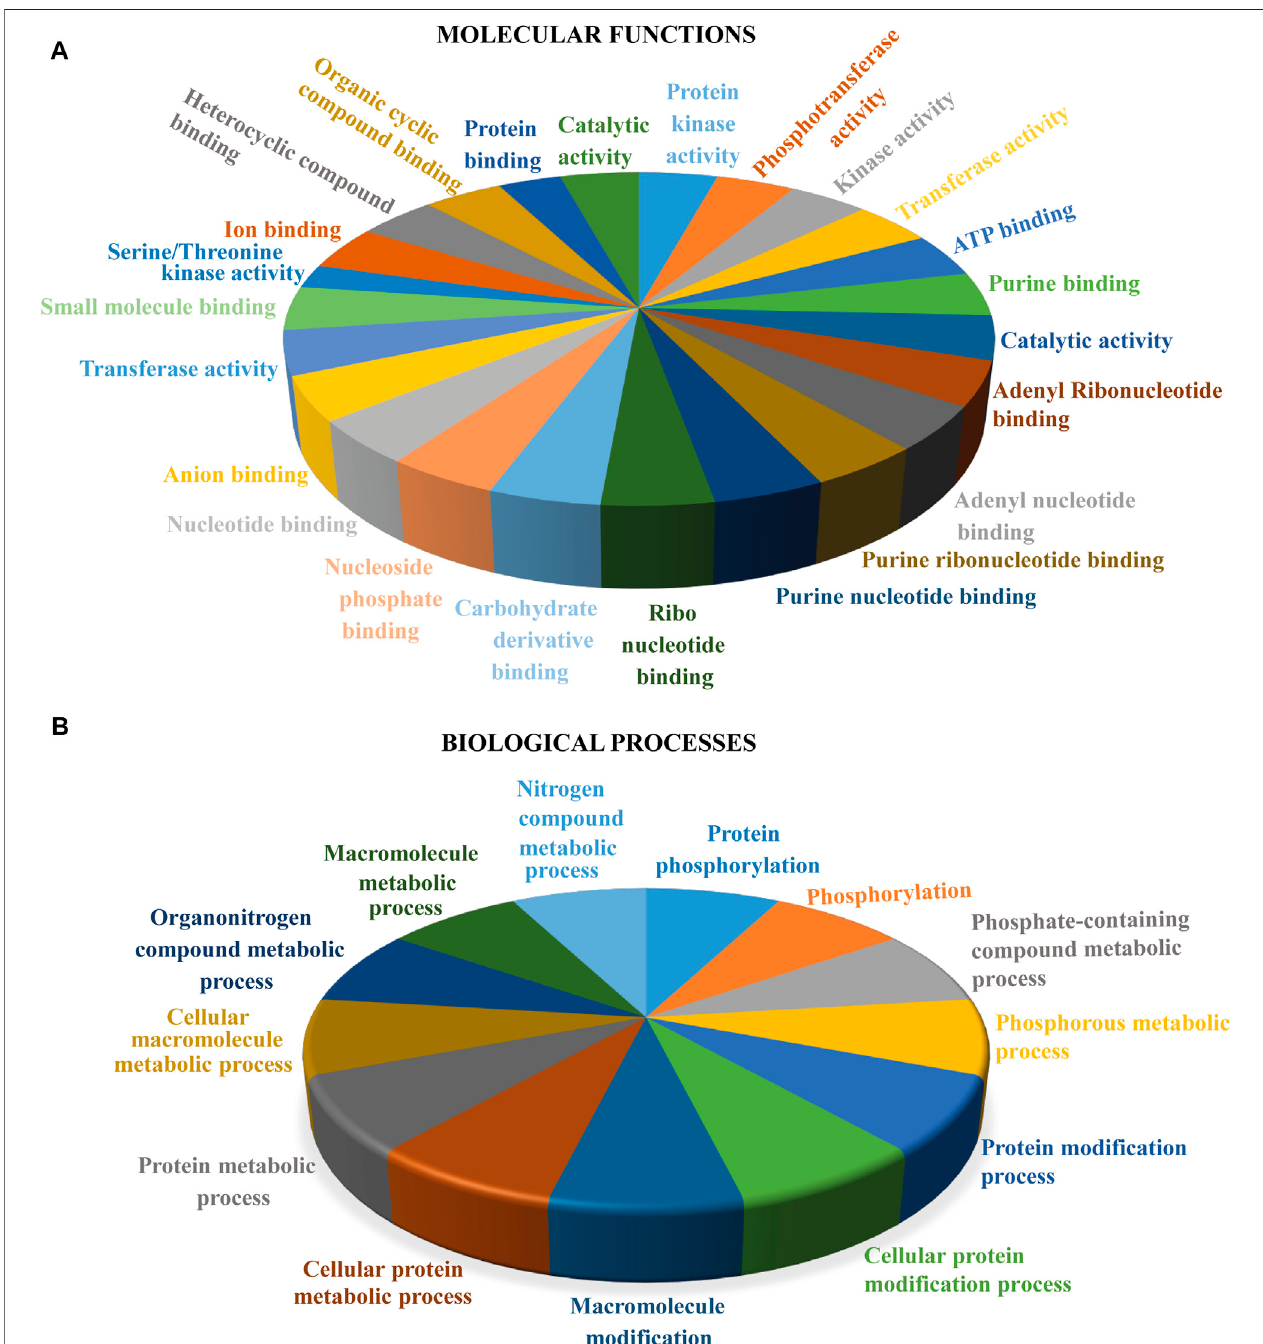
FIGURE 4 | Gene Ontology prediction of RPK1 genes. The data represent (A) molecular functions and (B) biological processes.